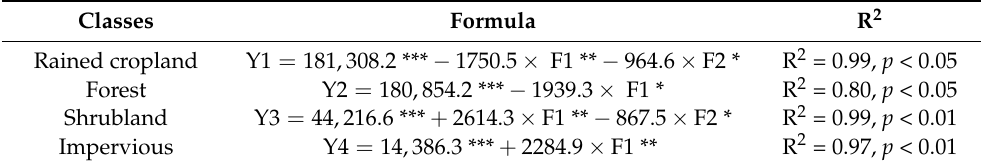
Table 5. Relationships between land cover change and principal components in different